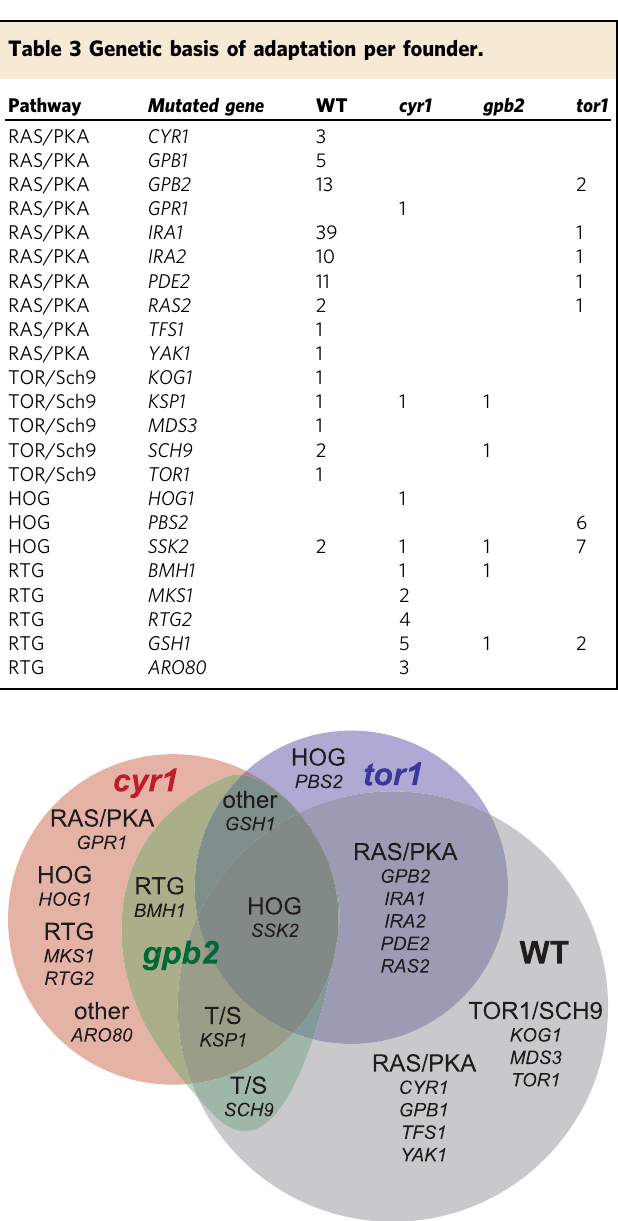
Fig. 4 Overlap in the mutational recurrent targets among adaptive and wild-type ancestors. The pathway and the gene names are annotated in each area. For number of hits, see Table 3. T/S stands for TOR/Sch9. WT stands for Source data for Fig. 3 for a more complete list). The bene fi cial